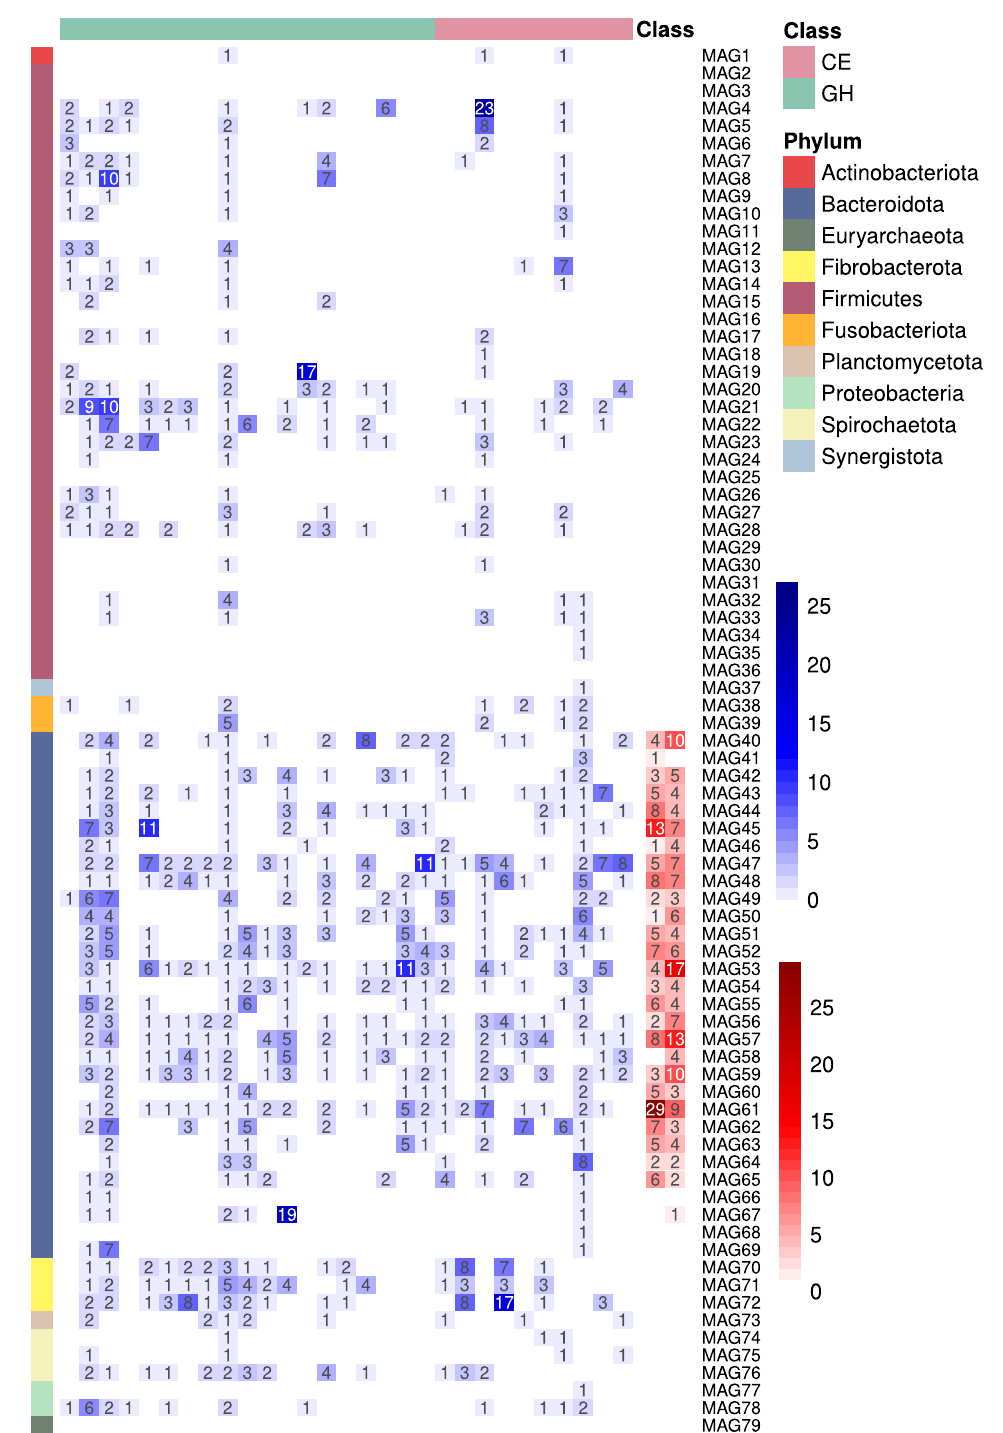
Fig. 4 Heatmap of main carbohydrate-active enzymes (CAZymes) families, polysaccharide utilization loci (PULs) and clusters of CAZymes (CCs) identi fi ed in the recovered metagenome-assembled genomes (MAGs). The heatmap indicates the number of genes encoding CAZymes, PULs, and CCs. The number of PULs and CCs are colored in a red scale, whereas the number of proteins in each family are in a blue